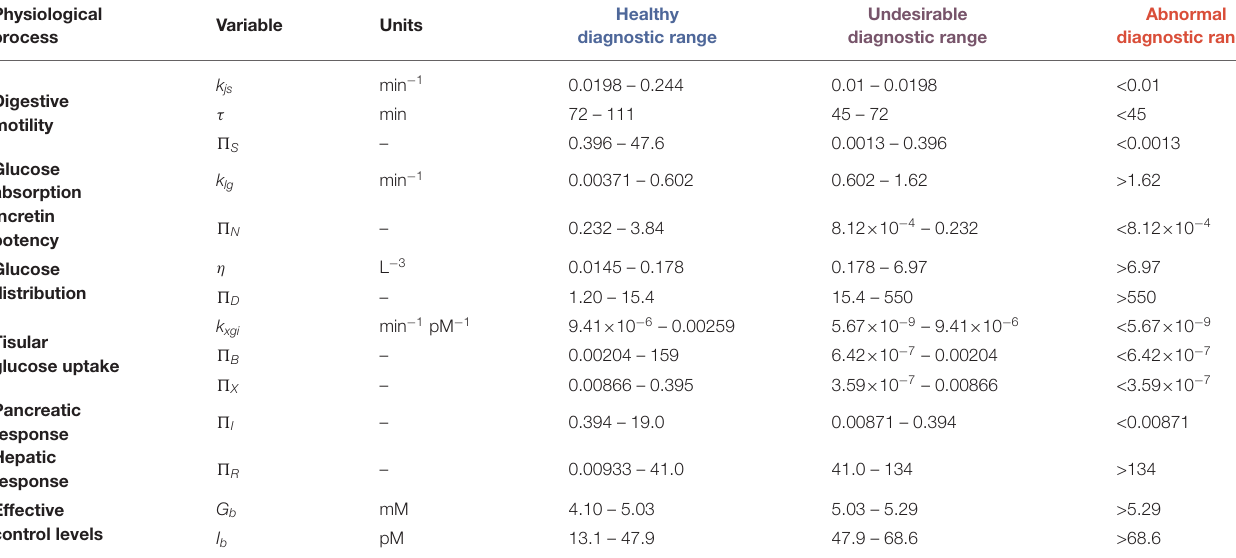
TABLE 1 | Healthy, undesirable and abnormal diagnostic ranges for model physiological parameters/NDNs. Physiological